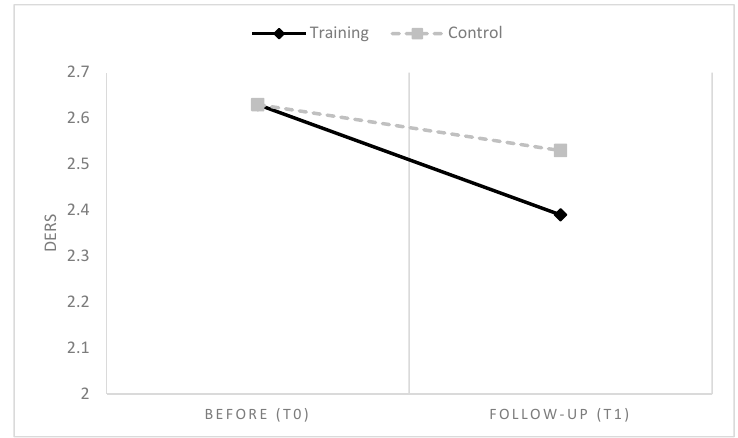
Figure 4. Mean di ff erences between groups and time in DERS. Figure 4. Mean differences between groups and time in DERS.